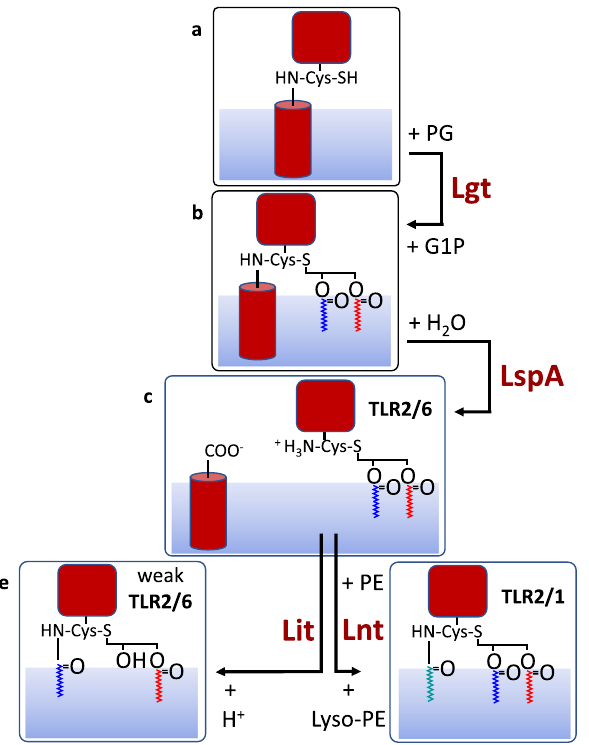
Fig. 1 Bacterial lipoprotein cysteine-based post-translational modi fi cation pathways. a Preprolipoprotein is converted to ( b ) prolipoprotein by the action of Lgt which uses PG as the lipid substrate. G1P is the second product of the reaction. Prolipoprotein is cleaved by the signal peptidase II, LspA, generating ( c ) apo-lipoprotein and signal peptide. In Gram-negative bacteria, Lnt N -acylates the apo-lipoprotein using PE forming ( d ) triacylated lipoprotein and lyso-PE. In low-GC% Gram-positive bacteria such as B. cereus and E. faecalis , Lit performs an intramolecular transacylation on apo- lipoprotein forming ( e ) lyso-lipoprotein. Lipoprotein interactions with receptors, TLR2/1 and TLR2/6, are indicated in c – e . A different type of lipoprotein, where processing involves signal peptidase I cleavage